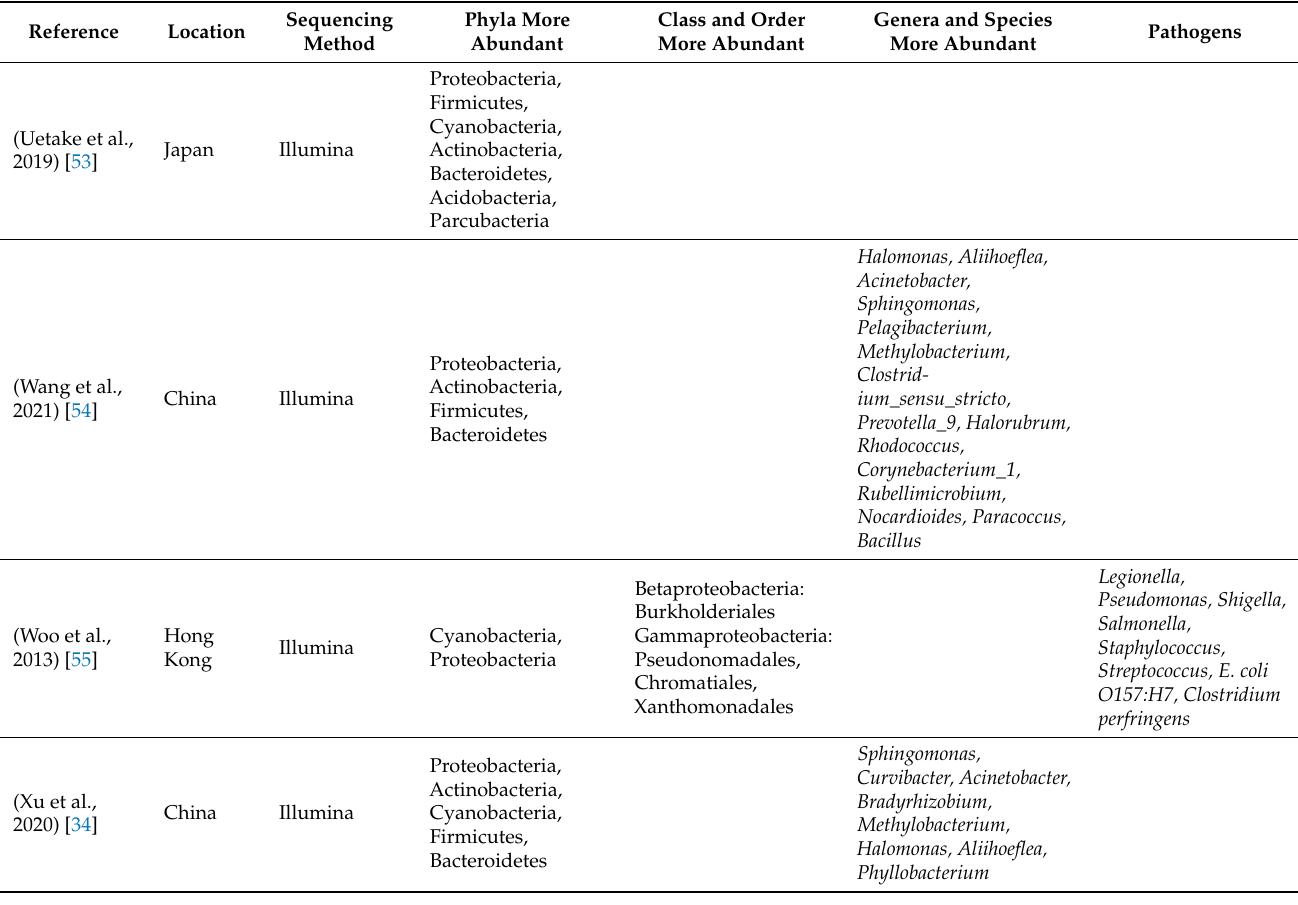
Table 2. Parameters that affect the microbial community: microorganisms’ emission sources, environmental and meteorological factors, and the season in which the alpha diversity was higher reported by each selected paper. Strength (indicated with ) and criticalities ( ) for each paper are reported.